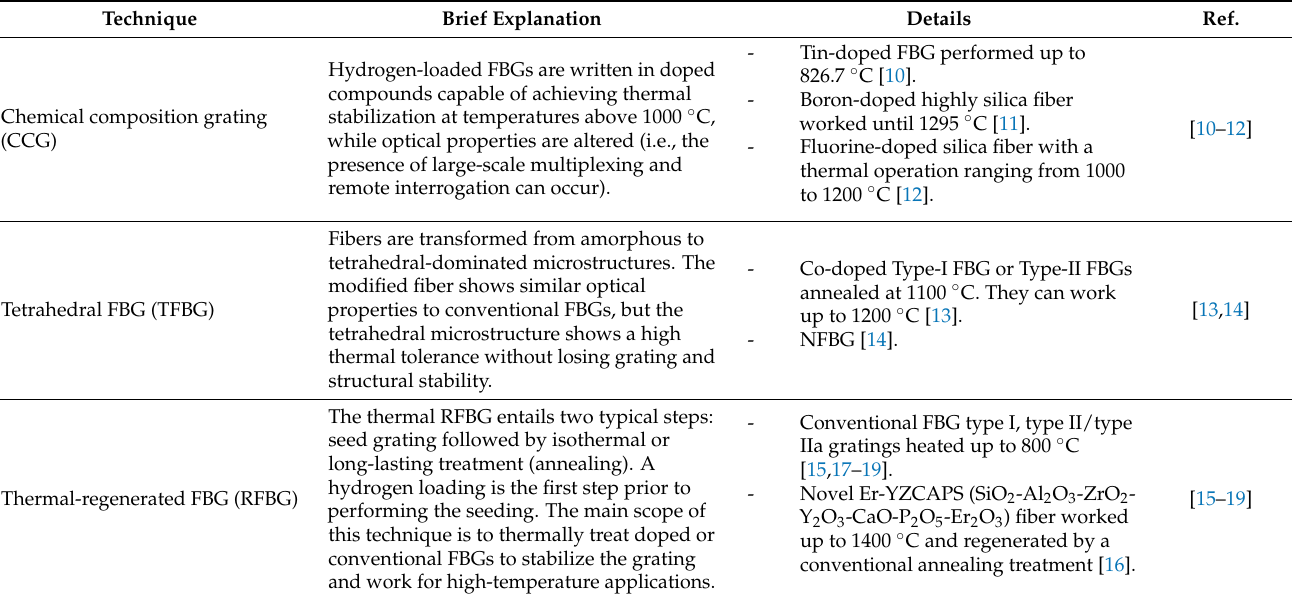
Table 1. Summary of regeneration techniques for high-temperature FBG